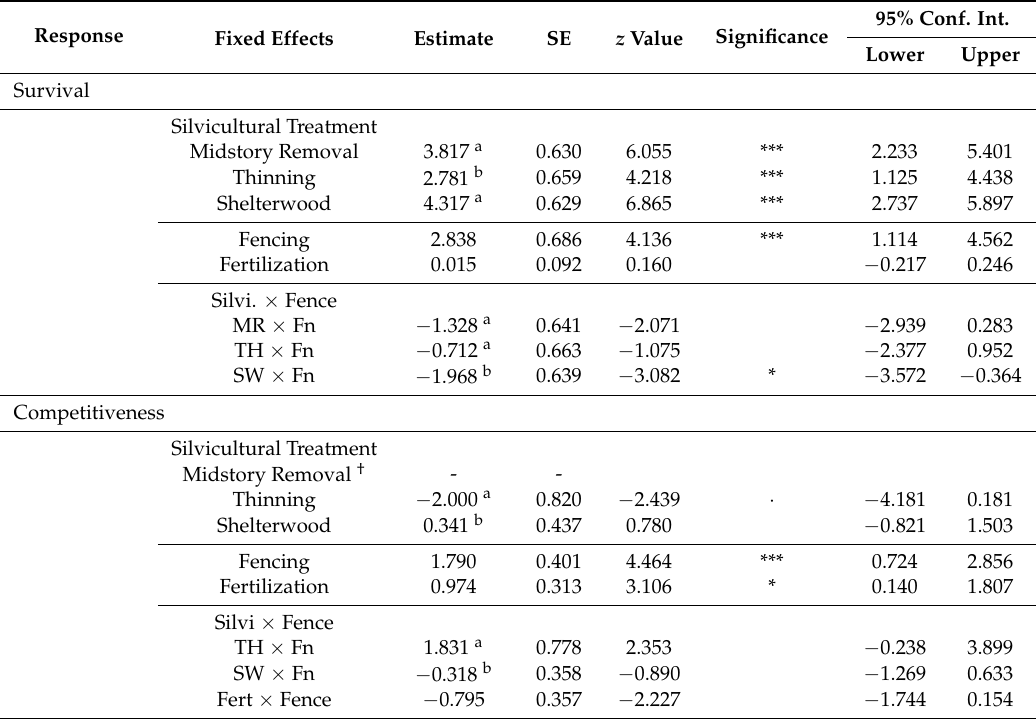
Table 2. Results of mixed-effects logistic regression analyzing the effects of silvicultural treatments, fencing, and fertilization on 10-year survival and competitiveness of underplanted northern red oak ( Quercus rubra L.) seedlings. Coefficients are presented on the log-odds scale.